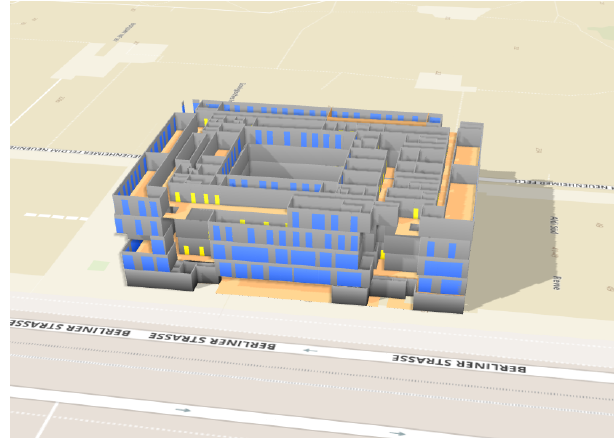
Figure 10: The building model without visualizing walls and